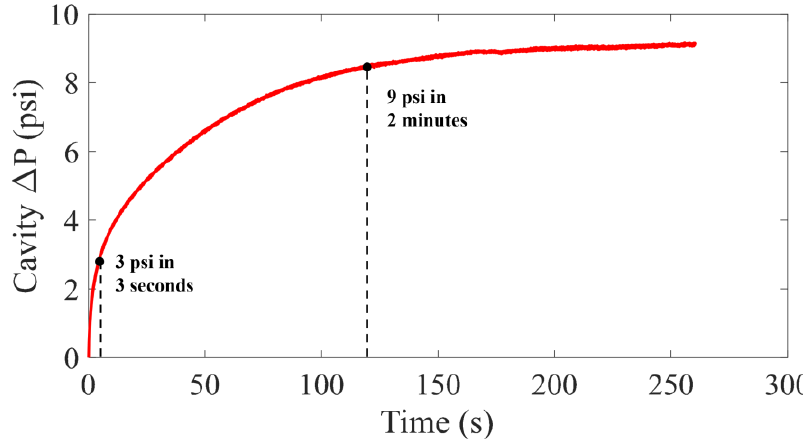
Figure 7. Measured cavity pressure after powering on the cavity heater.